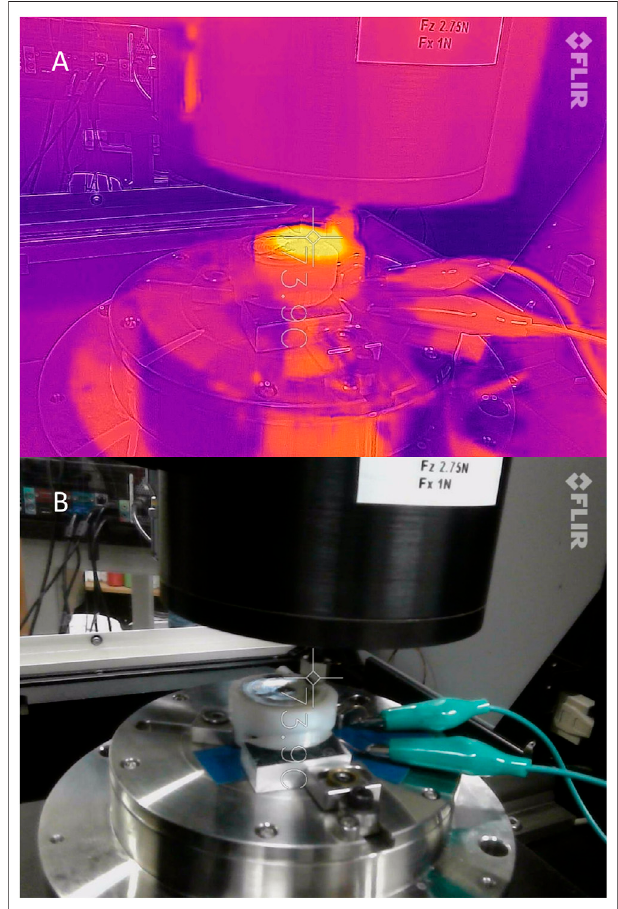
FIGURE 5 | Snapshots captured by a thermal camera to measure the surface temperature of the composite pad during the experiments. (A) Thermal view. (B) Normal view.